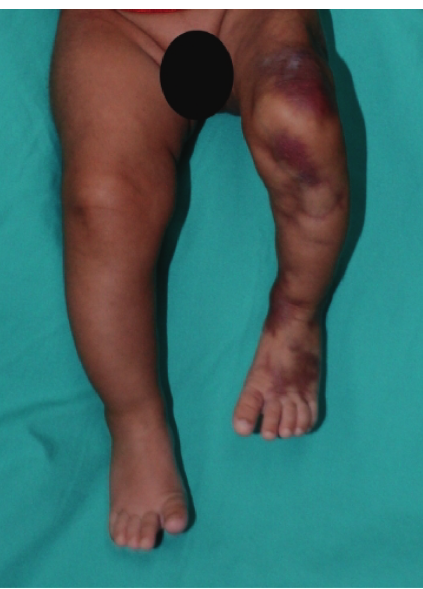
Figure 1: Cutis marmorata telangiectatica congenita on the left lower limb associated with ipsilateral hemiatrophy (anterior view).